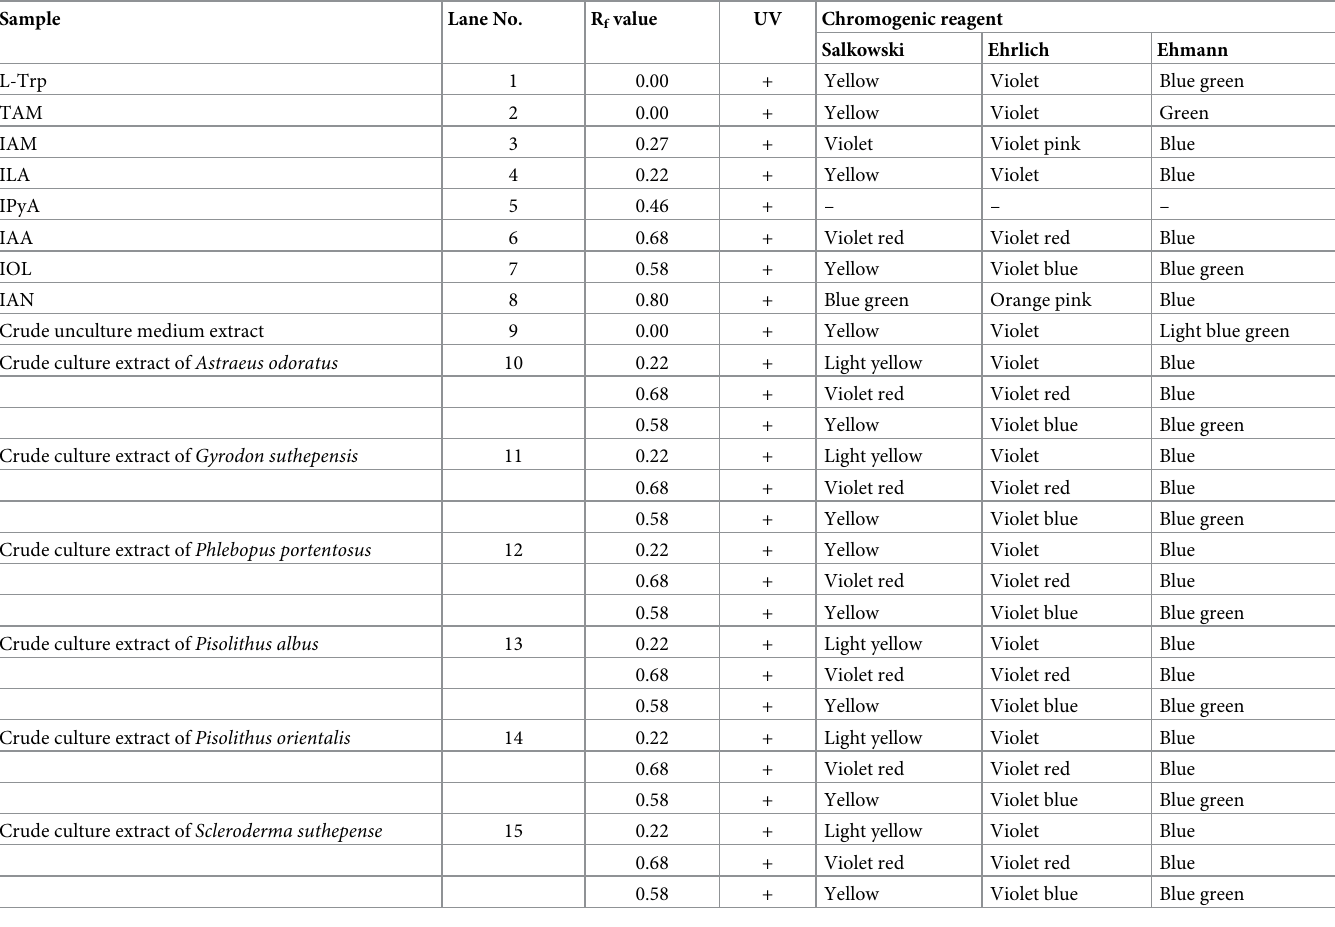
Table 2. Identification of indole compounds extracted from a culture of ectomycorrhizal fungi using chromogenic reagents after TLC separation. Sample